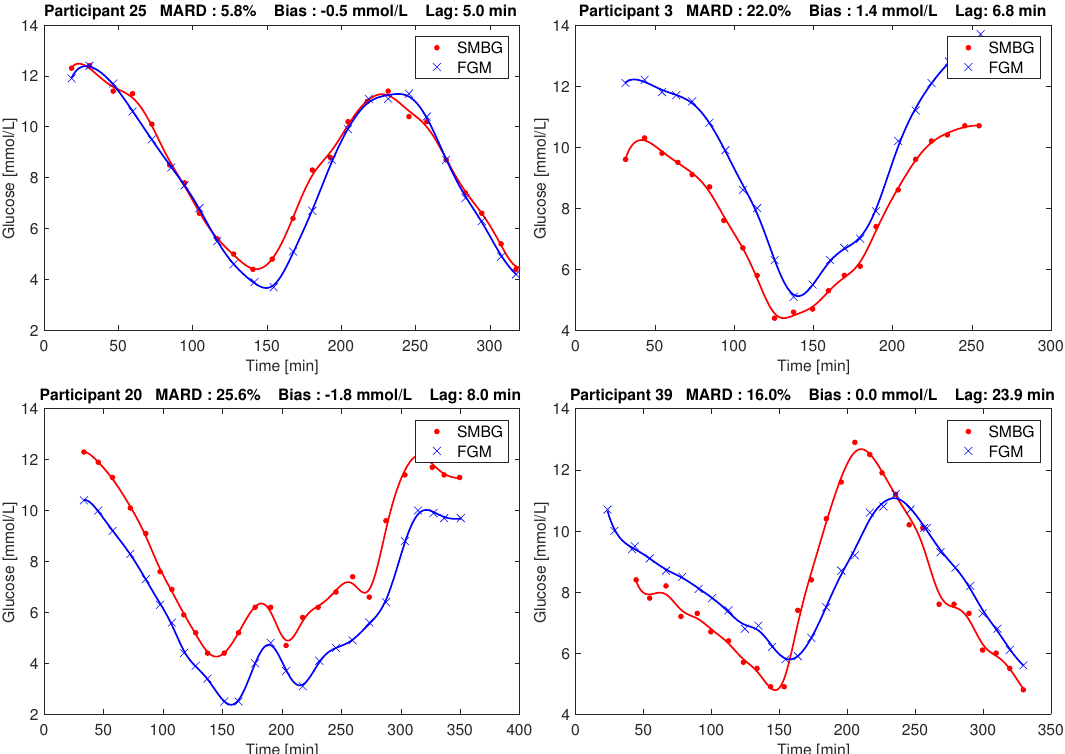
Figure 1. Examples of Flash Glucose Monitor (FGM) and Self Monitoring of Blood Glucose (SMBG) recordings in our study. Top left: Low Mean Absolute Relative Difference (MARD). Top right: Large positive bias. Bottom left: Large negative bias. Bottom right: Large lag. Points are measurements,